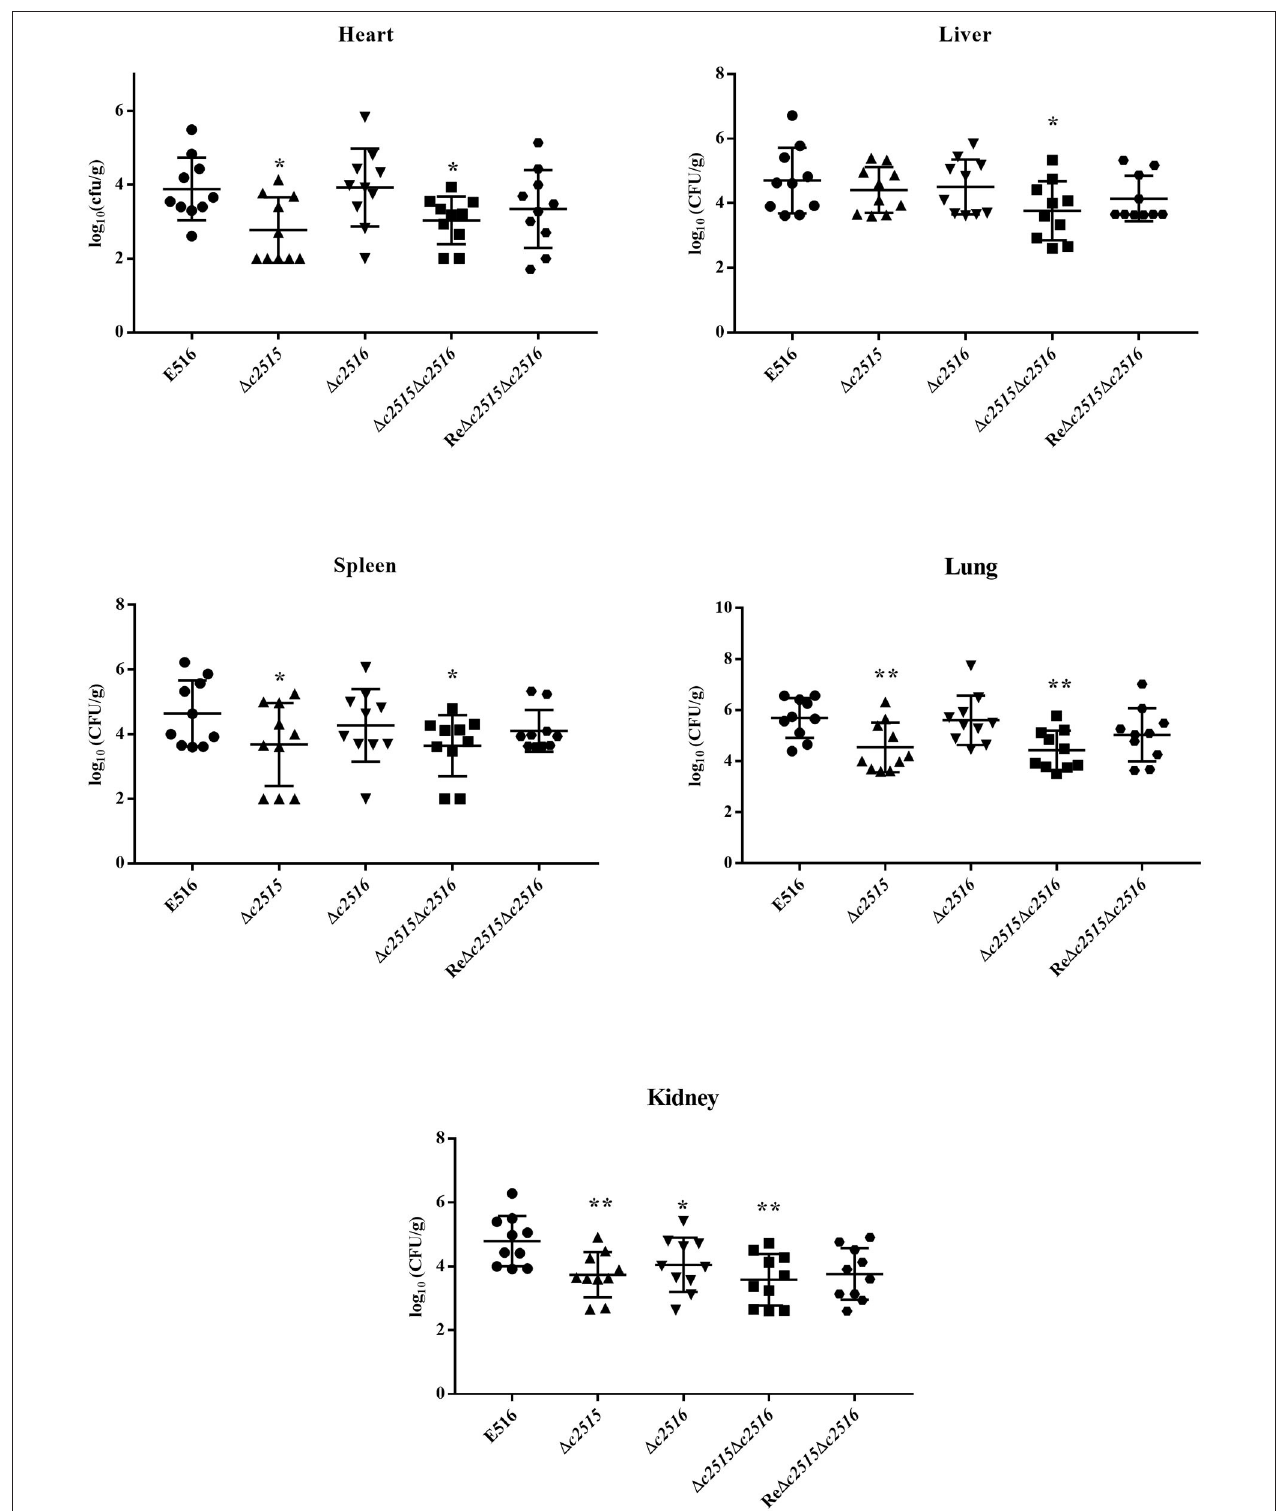
FIGURE 6 | Colonization of the WT strain E516 ( • ), 1 c2515 ( N ), 1 c2516 ( H ), 1 c2515 1 c2516 ( (cid:4) ) and Re 1 c2515 1 c2516 ( ’ ) during systemic infection. A, Heart; B, Liver; C, Spleen; D, Lung; E, Kidney. Data were presented as log 10 (CFU/g) of tissues. Horizontal bars indicated the mean values. Each data represented a sample from an individual chicken. Statistically significances as determined by the Mann-Whitney-test were indicated by asterisks (* P < 0.05; ** P < 0.01).